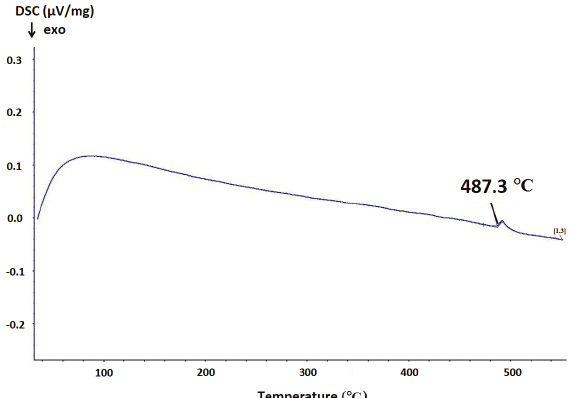
Figure 3. Temperature dependent DSC (µV/mg ) revealing a peak at ≈ 490 °C further signifying the presence of